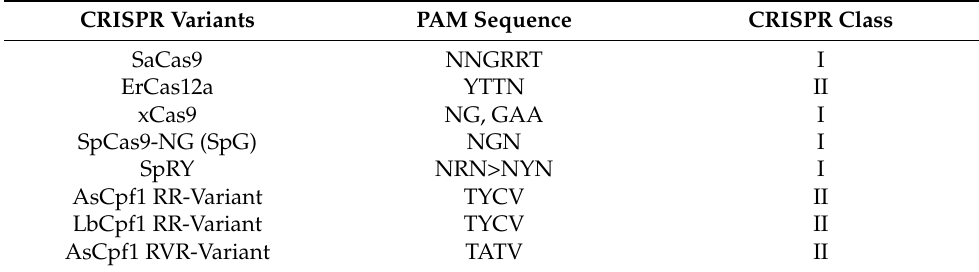
Table 1. List of CRISPRs with compatible PAMs that enable targeting within a conventional lox